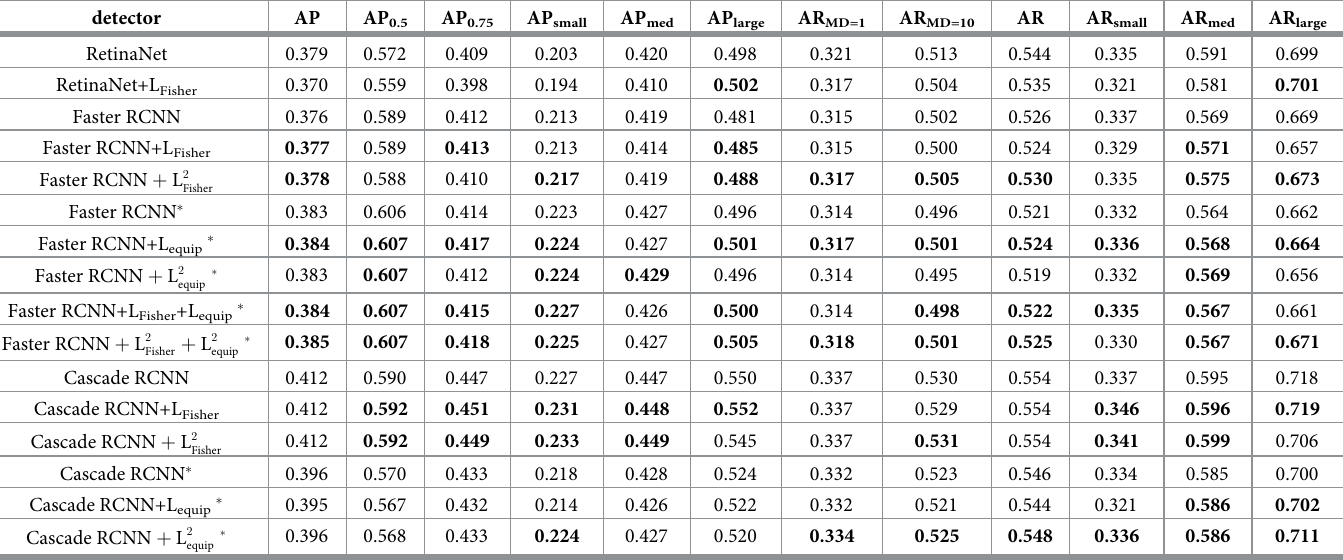
Table 1. Ablation evaluations of structural constraint mechanism on MSCOCO2017